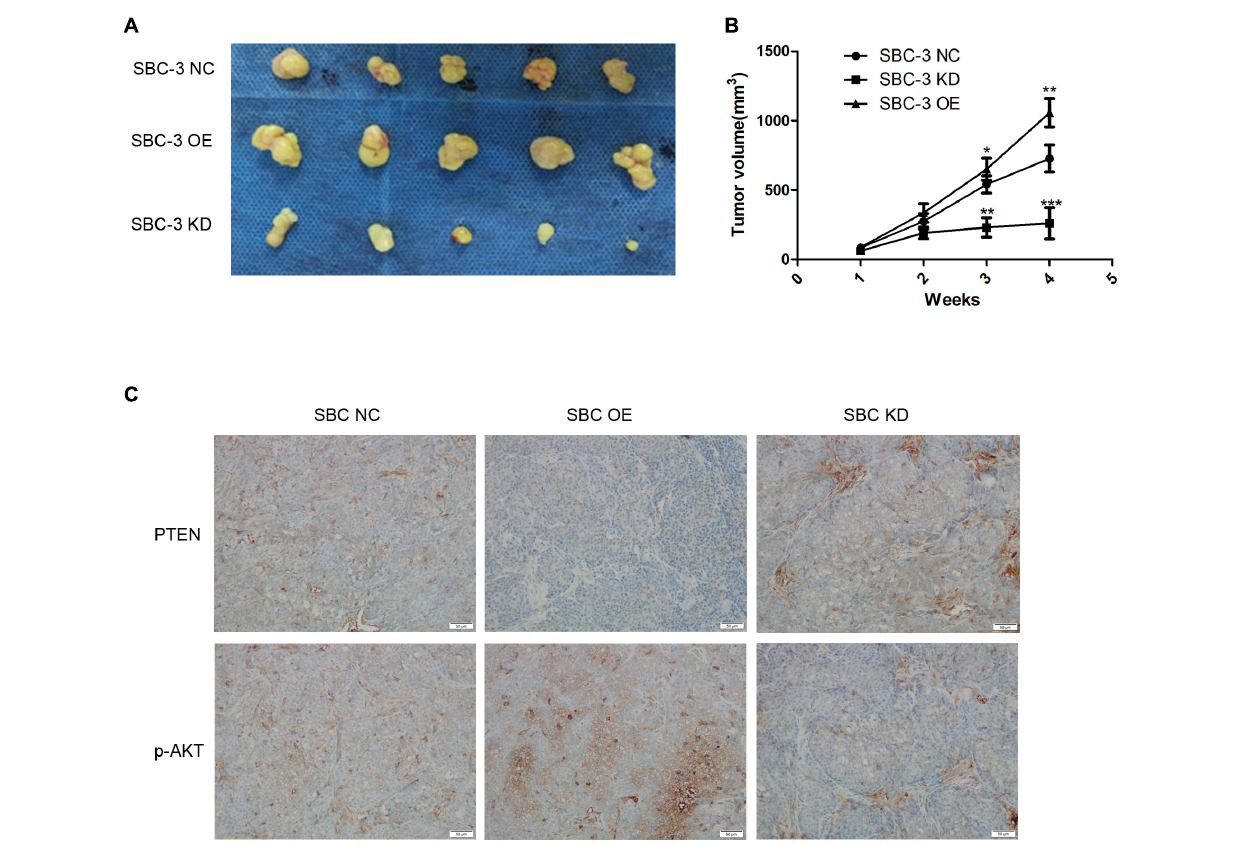
FIGURE 5 | MiR-92b-3p promotes SCLC development through the PTEN/AKT pathway in vivo . (A,B) The tumor-forming ability of SBC-3 cells with different miR-92b-3p expression levels. MiR-92b-3p promoted the tumor growth in vivo. Compared with SBC-3 NC group, * P < 0.05, ** P < 0.01, and *** P < 0.001. (C) After miR-92b-3p overexpression, the IHC data confirmed that PTEN levels were down-regulated while p-AKT levels were up-regulated in tumor tissue. SCLC, small cell lung cancer and IHC,